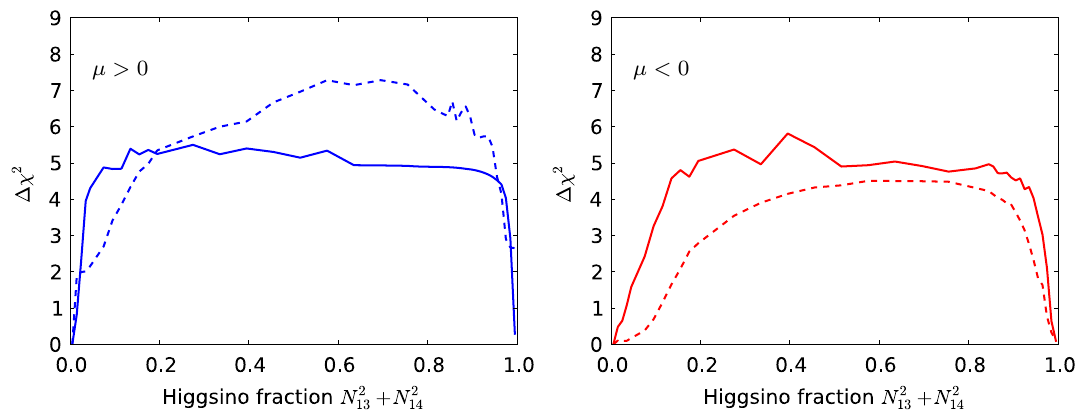
lines , respectively. The lowest- χ 2 point in the Higgsino-LSP region Fig. 5 Profiled (cid:9)χ 2 of the ˜ χ 0 Higgsino fraction for μ > 0 ( left panel ) 1 = (cid:4) + N 2 (cid:4) 1) has very similar χ 2 to the wino-LSP best-fit point and for μ < 0 ( right panel ). The profiles for the (cid:4) ˜ χ 0 ( N 2 CDM 13 14 1 ≤ (cid:4) case and for the (cid:4) ˜ χ 0 CDM case are shown as solid and dashed 1 Table 2 Fit results for the mAMSB assuming that the LSP makes the relevant numbers of degrees of freedom (including the electroweak pre- dominant contribution to the cold dark matter density. The 68% CL cision observables) using the standard prescription [82]. Each mass ranges correspond to (cid:9)χ 2 = 1. We also display the values of the global range is shown for both the wino- and Higgsino-LSP scenarios as well χ 2 function omitting the contributions from HiggsSignals , and the as for both signs of μ corresponding χ 2 probability values calculated taking into account the